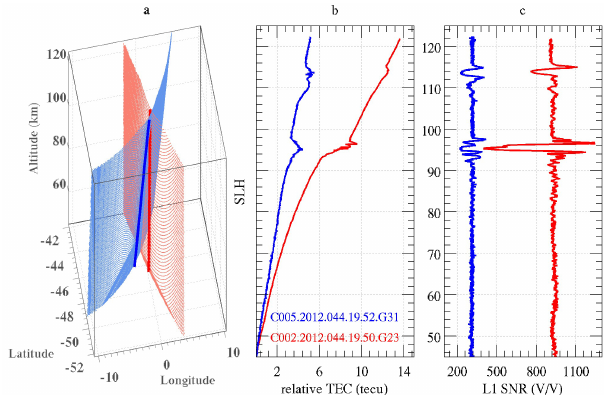
Figure 4. The same as Fig. 3 but for another case on day 106 of